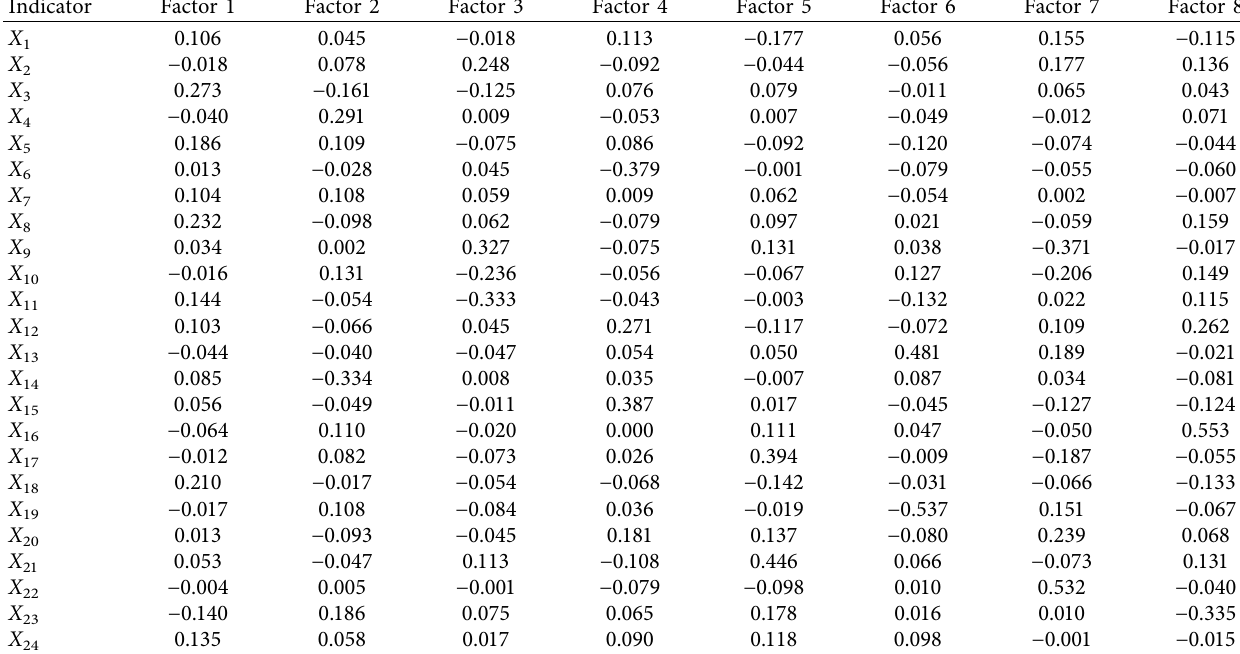
Table 18: The score coefficient matrix of the 8